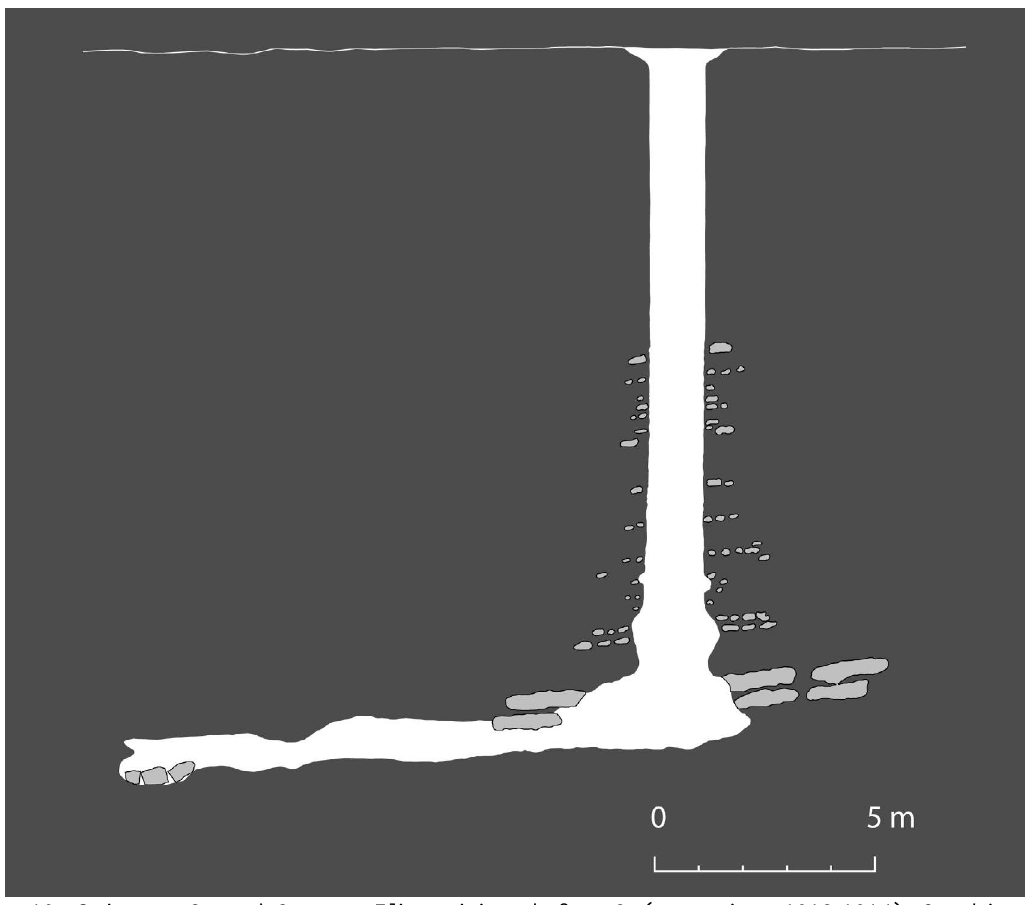
Figure 19. Spiennes, Camp-à-Cayaux. Flint mining shaft nr 2 (excavations 1912-1914). Graphics y M. Woodbury, SPW modified after Hubert (1978).